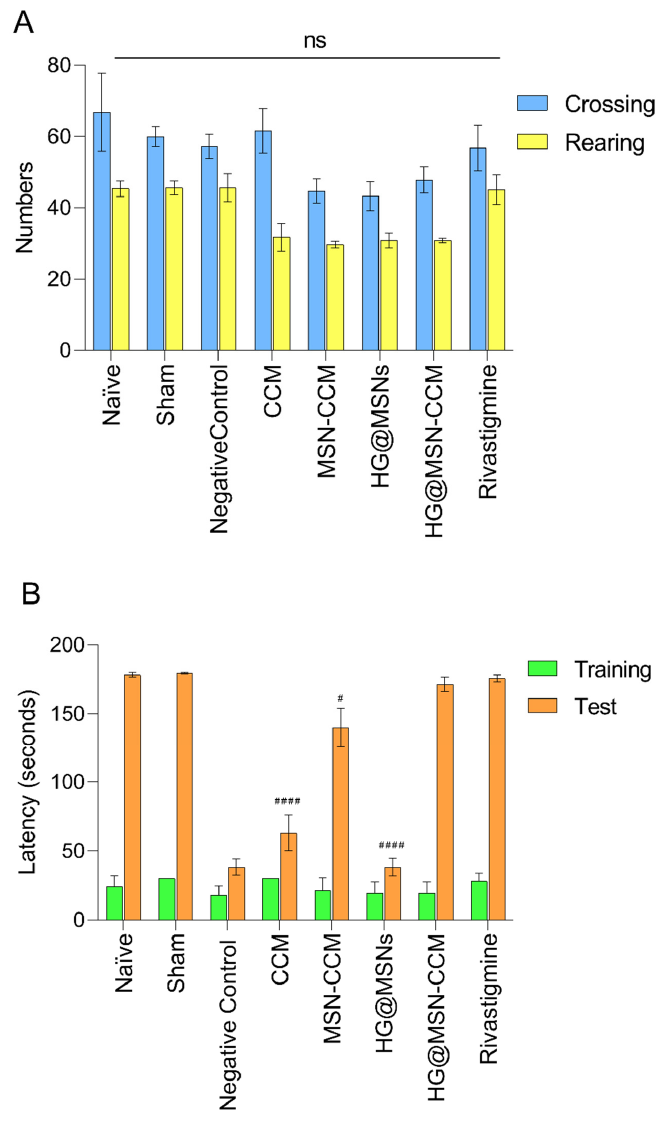
Figure 9. In vivo assay. Effects of treatment in the open field test ( A ) and inhibitory avoidance ( B ). Each bar represents the mean ± SD, from 6 to 12 animals per group. # p < 0.05, and #### p < 0.0001. The data were analyzed by the analysis of variance (ANOVA) and complemented by the Dunnett’s post hoc tests. ns = non-significant. The results of the inhibitory avoidance demonstrated that, in the training session, no significant differences were observed between groups ( p > 0.05). All mice spent about 12 to 30 s to get down on the platform and receive the shock. In the test session, groups that received i.c.v. injection of STZ (3 mg kg − 1 ) and were treated with MSN-CCM, HG@MSN-